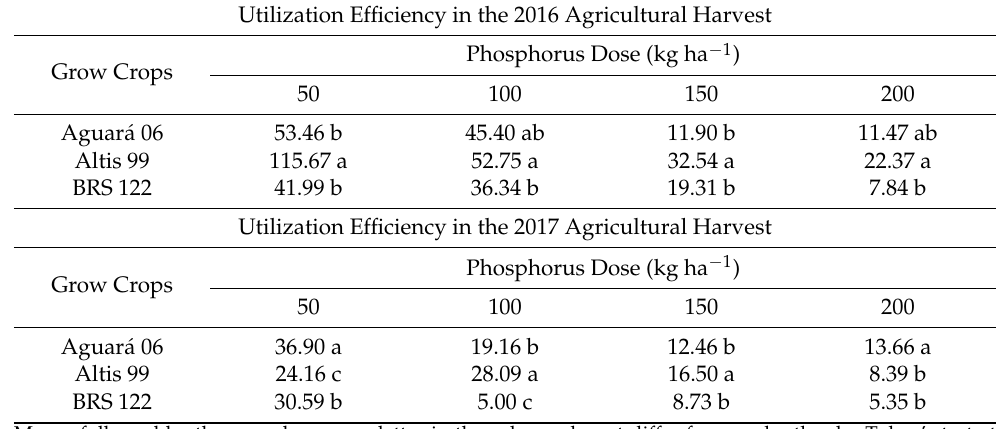
Table 5. Average values for utilization efficiency as a function of sunflower cultivars within phospho- rus doses in the 2016 and 2017 agricultural